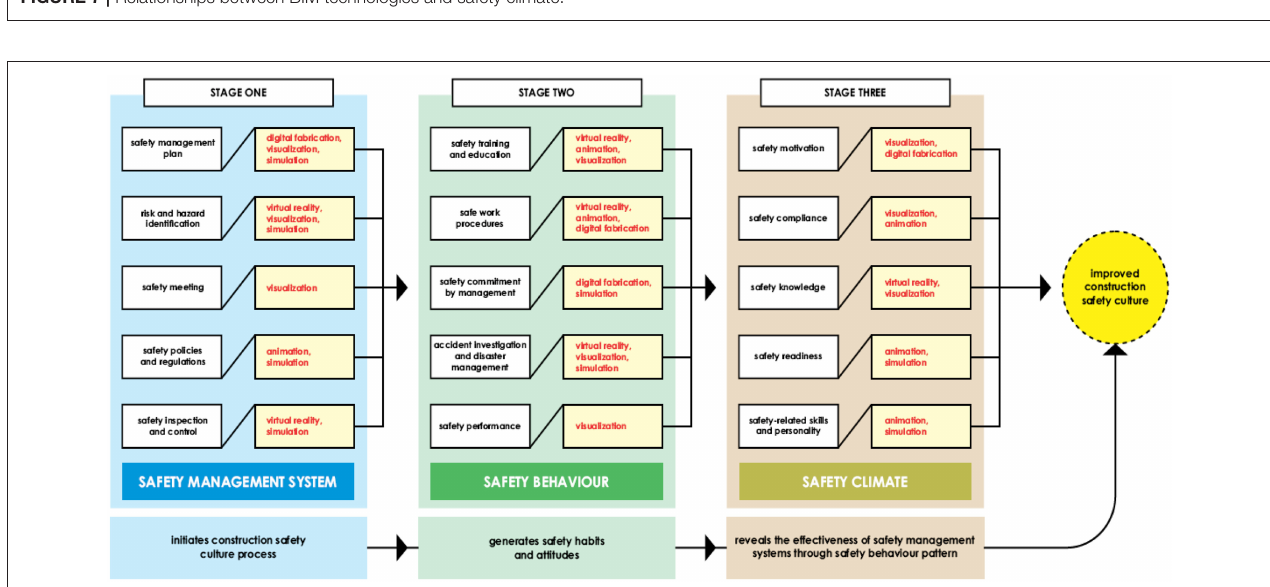
FIGURE 8 | A model of BIM-enabled construction safety culture and maturity